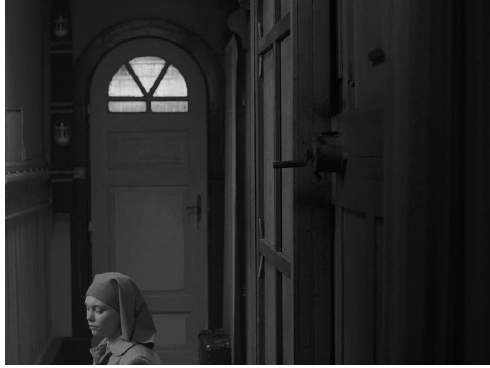
Figure 14. Early in a scene with balanced framing.